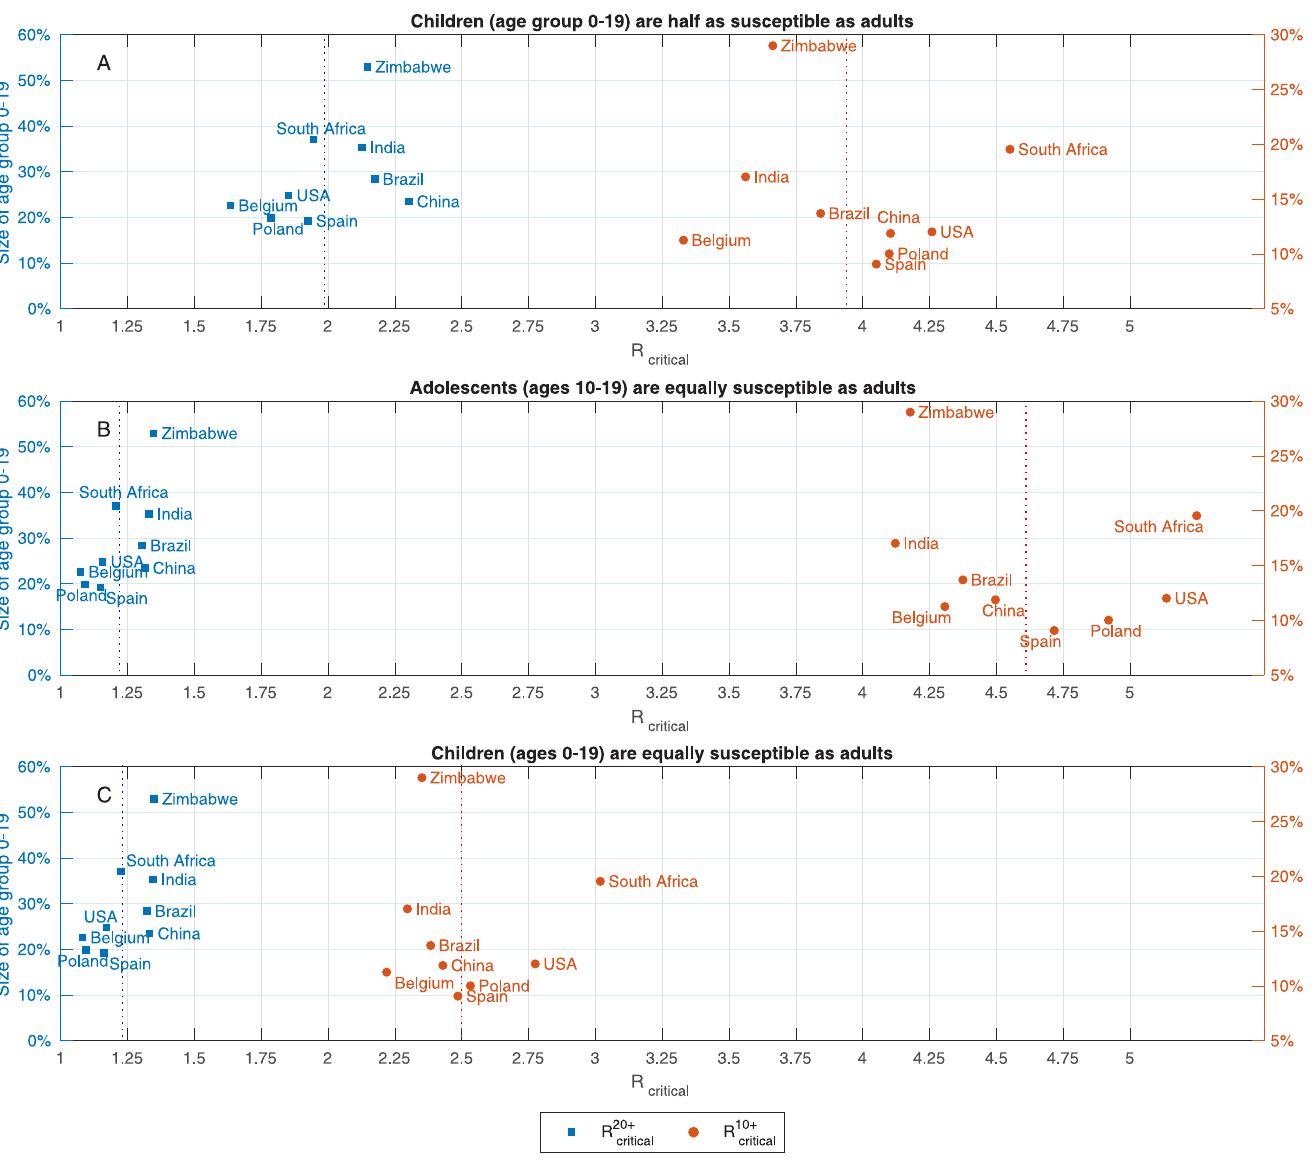
Fig 3. Critical reproduction numbers. Reproduction numbers R 20 þ and R 10 þ at which herd immunity cannot be achieved without vaccination of age groups 0 − 19 critical critical and 0 − 9, respectively. Computed using A: age-dependent susceptibility profile of SARS-CoV-19: Ages 0–19 are roughly half as susceptible as adults [15]. B: Same susceptibility profile as in A, but with increased susceptibility in the age group 10–19: Ages 10–19 are as susceptible as adults. C: Same susceptibility profile as in A, where ages 10–19 are as susceptible as adults.